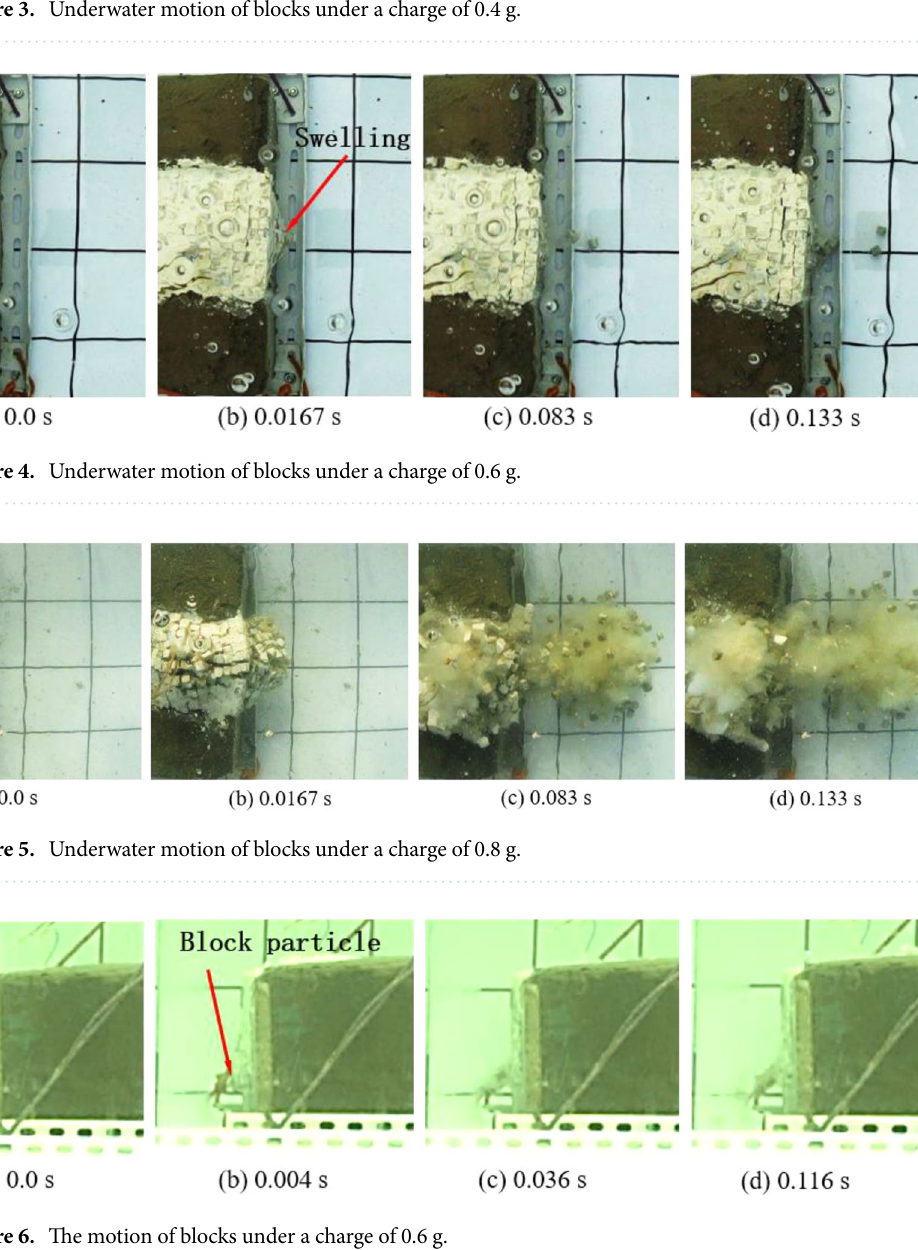
Figure 3. Underwater motion of blocks under a charge of 0.4 g.